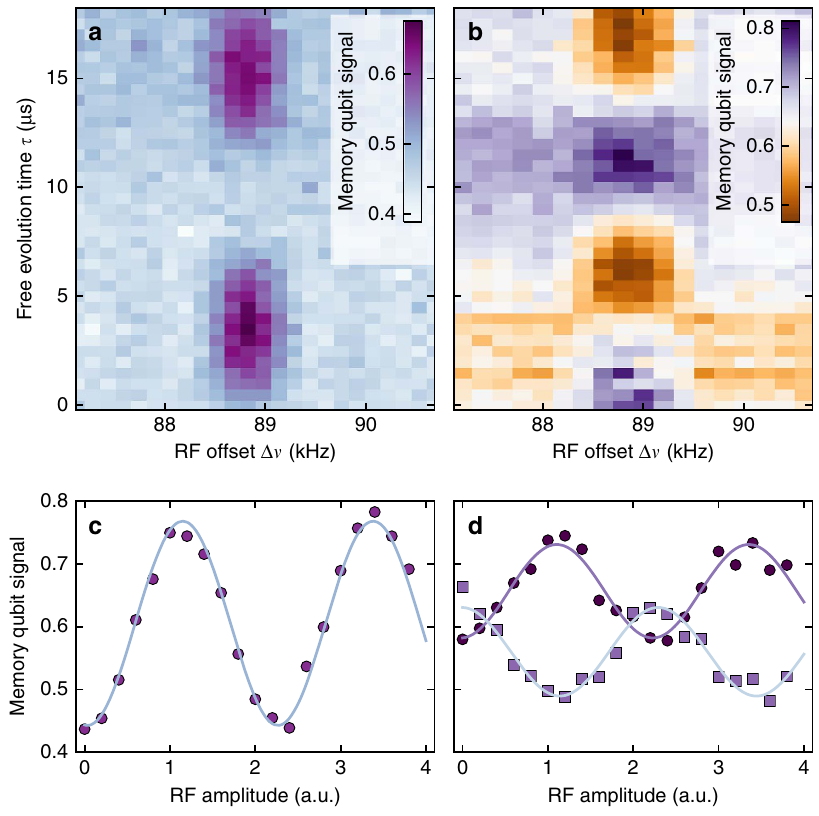
Figure 3 | Sensing a single nuclear spin. ( a , b ) Colour-coded memory qubit signals (that is, probability of detecting state 1 j i ) of enhanced correlation measurement with an RF pulse during T c ¼ 1ms. Sensing time t and RF pulse frequency offset D n to the bare 13 C Larmor frequency are varied (cf. Mims electron-nuclear-double-resonance (ENDOR) 29 ). A resonance of a 13 C spin around D n ¼ 89kHz appears, where, for increasing t , the phase D f of the memory increases. The width of the 13 C spin controlled phase accumulation of about 1kHz is governed by the RF pulse duration. a , b show cos D f and sin D f of the memory phase because the phase j of the final memory qubit p /2-pulse is set to 0 ( a ) and p /2 ( b ) (see Fig. 1c). Please note, that for the measurements done with j ¼ p = 2 ( b ) initialization of the 13 C spin is required (here: spin down, see main text). Variations of the background in panel ( b ) are due to drifts of D o (see equation 6, see the ‘Methods’ section). ( c , d ) On resonance, the RF pulse amplitude is varied, to induce Rabi oscillations of the detected 13 C spin. Phases j are 0 in ( c ) and ± p /2 in ( d ) for circles and